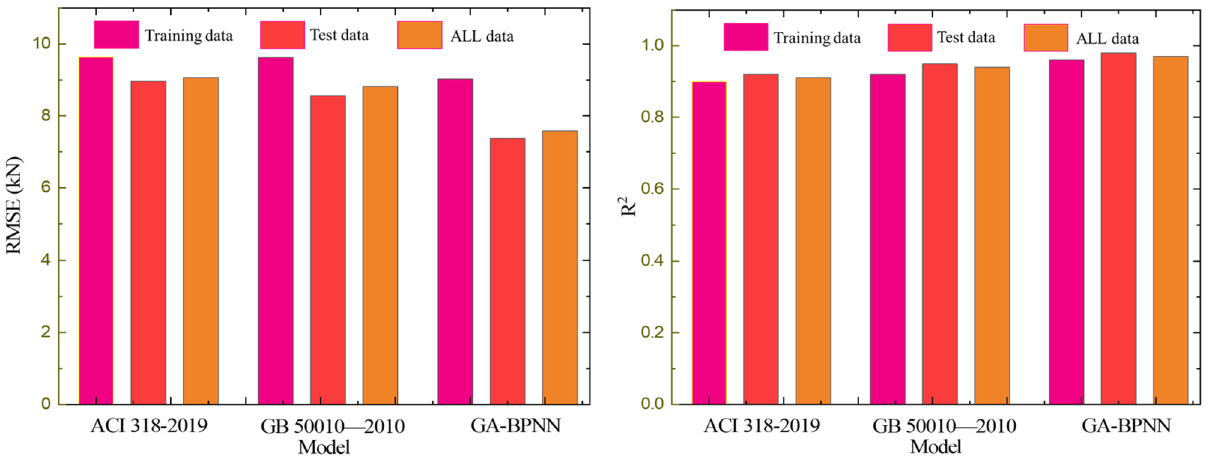
Figure 18. Statistical results of model performance.